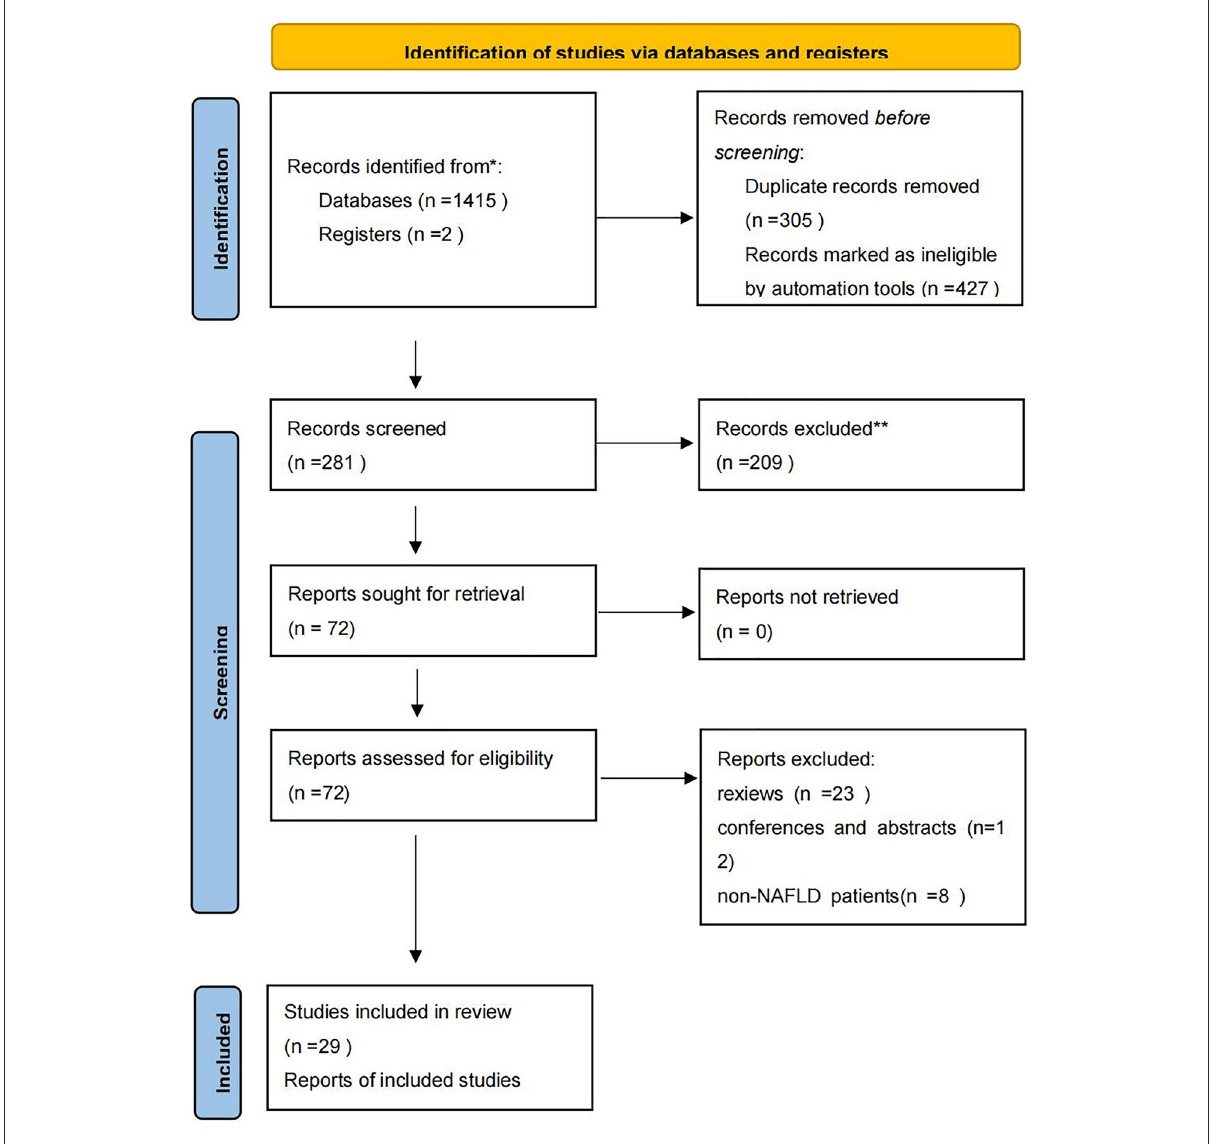
FIGURE1 PRISMA flow